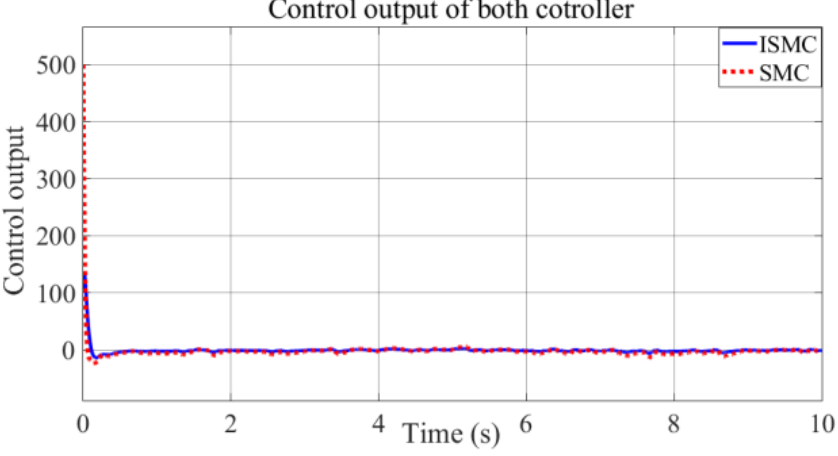
Figure 11. Control output of both control schemes.